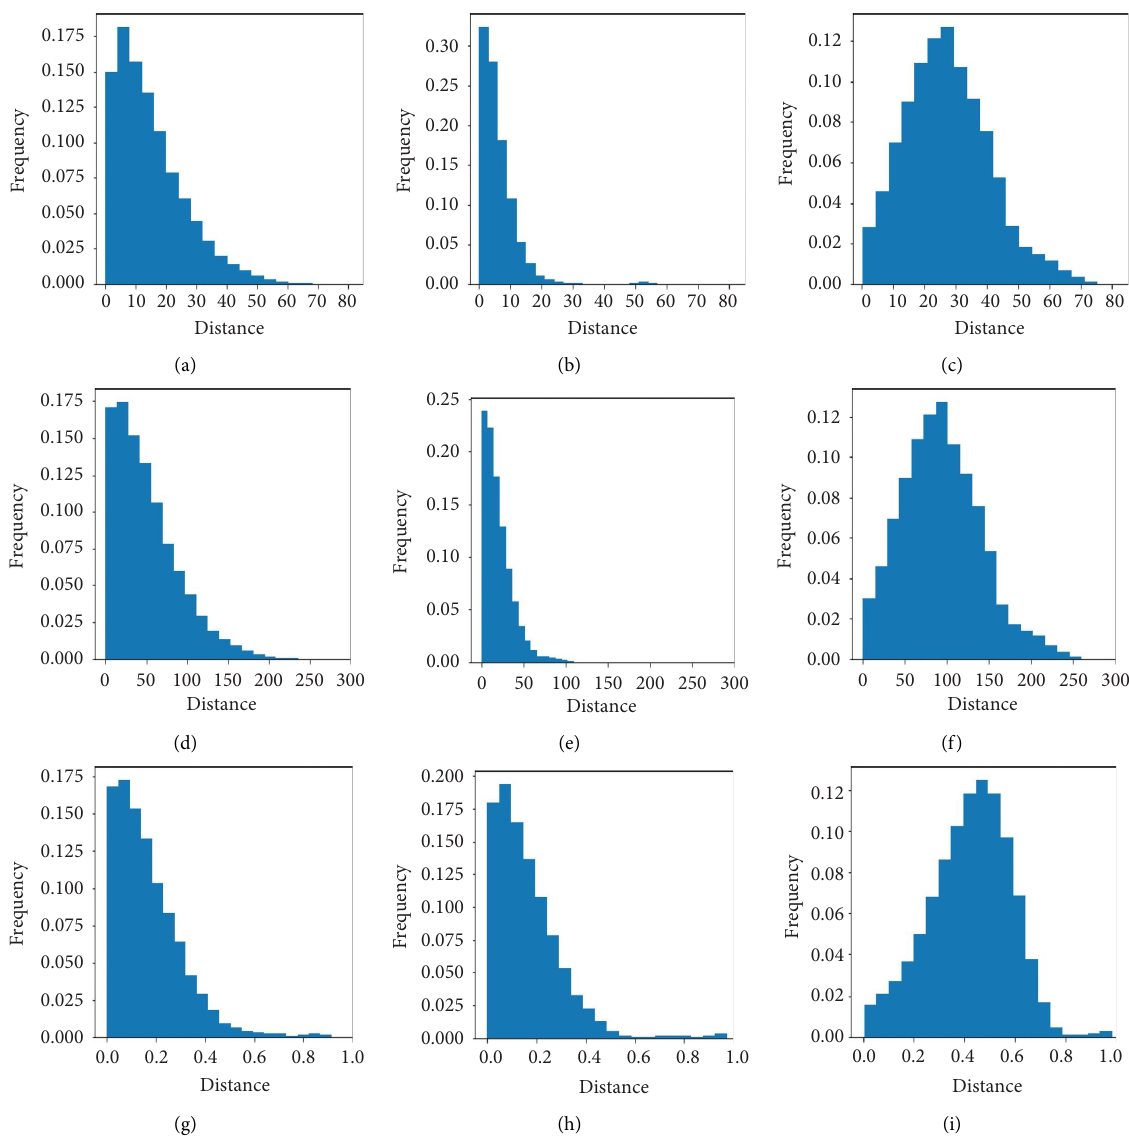
Figure 2: Histograms of diferent distances for feature vector f � f k � 12, where x label denotes the distance between two feature p with 1 vectors and y label denotes the frequency of the corresponding distance values in all the calculated distances. First column: distance histogram between windshear cases. Second column: distances between non-windshear cases. Tird column: distances between windshear and non-windshear cases. Top row: histograms of the Euclidean distance. Second row: histograms of the city block distance. Bottom row: histograms of the Bray–Curtis